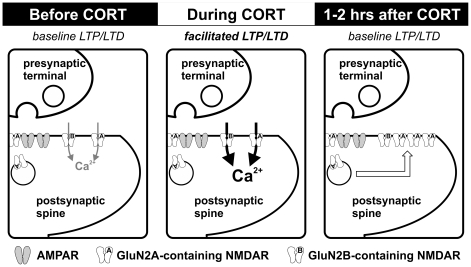
CORT-induced dynamic regulation of synaptic NMDARs in the adult hippocampus.Schematic diagrams summarize the impact of CORT on NMDAR function and synaptic plasticity. Compared with controls (left), stress level CORT treatment (100 nM, 30 min) induces a fast-onset increase in synaptic NMDAR function, possibly caused by increased NMDAR channel function or cleft glutamate availability (center). Notably, both LTP and LTD are facilitated during CORT treatment. However, 1–2 hours after the end of CORT treatment, we observed enhancement of the surface expression of GluN2A-containing NMDAR (right). This slow-onset increase in GluN2A/GluN2B ratio after CORT treatment could have a homeostatic role for normalizing the facilitated synaptic plasticity.